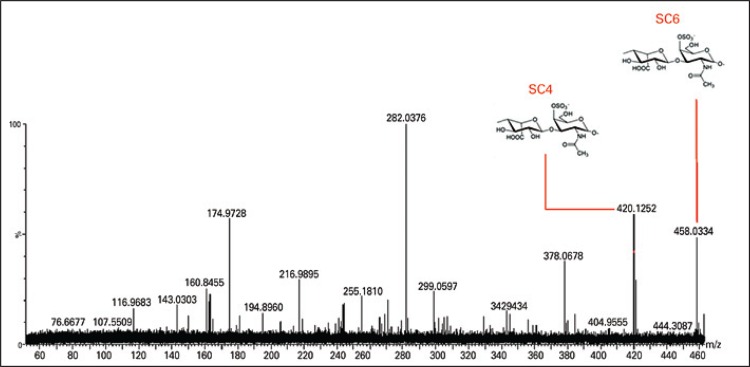
Espectroscopia de massa para identificar oligossacarídeos de sulfato de condroitina. Os oligossacarídeos e dissacarídeos de sulfato de condroitina foram obtidos após digestão com condroitinase AC. Os produtos foram comparados com o padrão de produtos de condroitina-4-sulfatada e condroitina-6-sulfatada